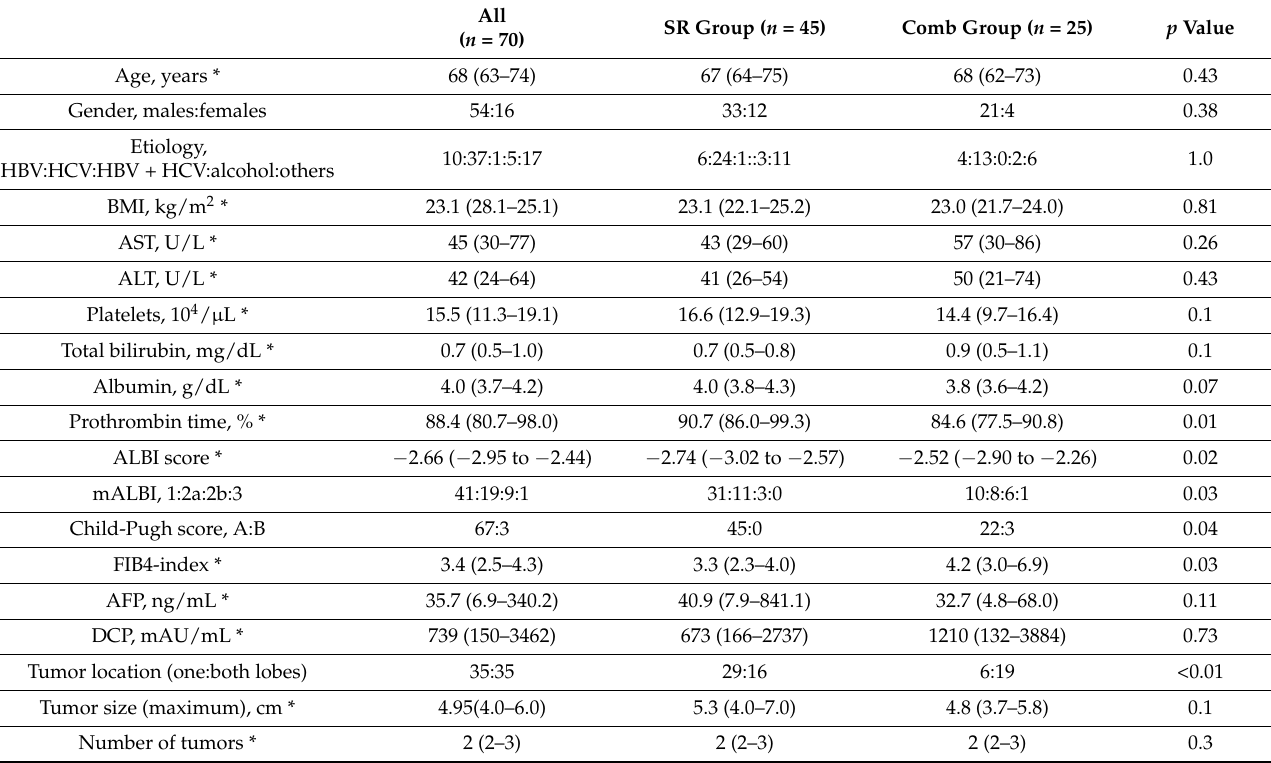
Table 1. Patient characteristics ( n =